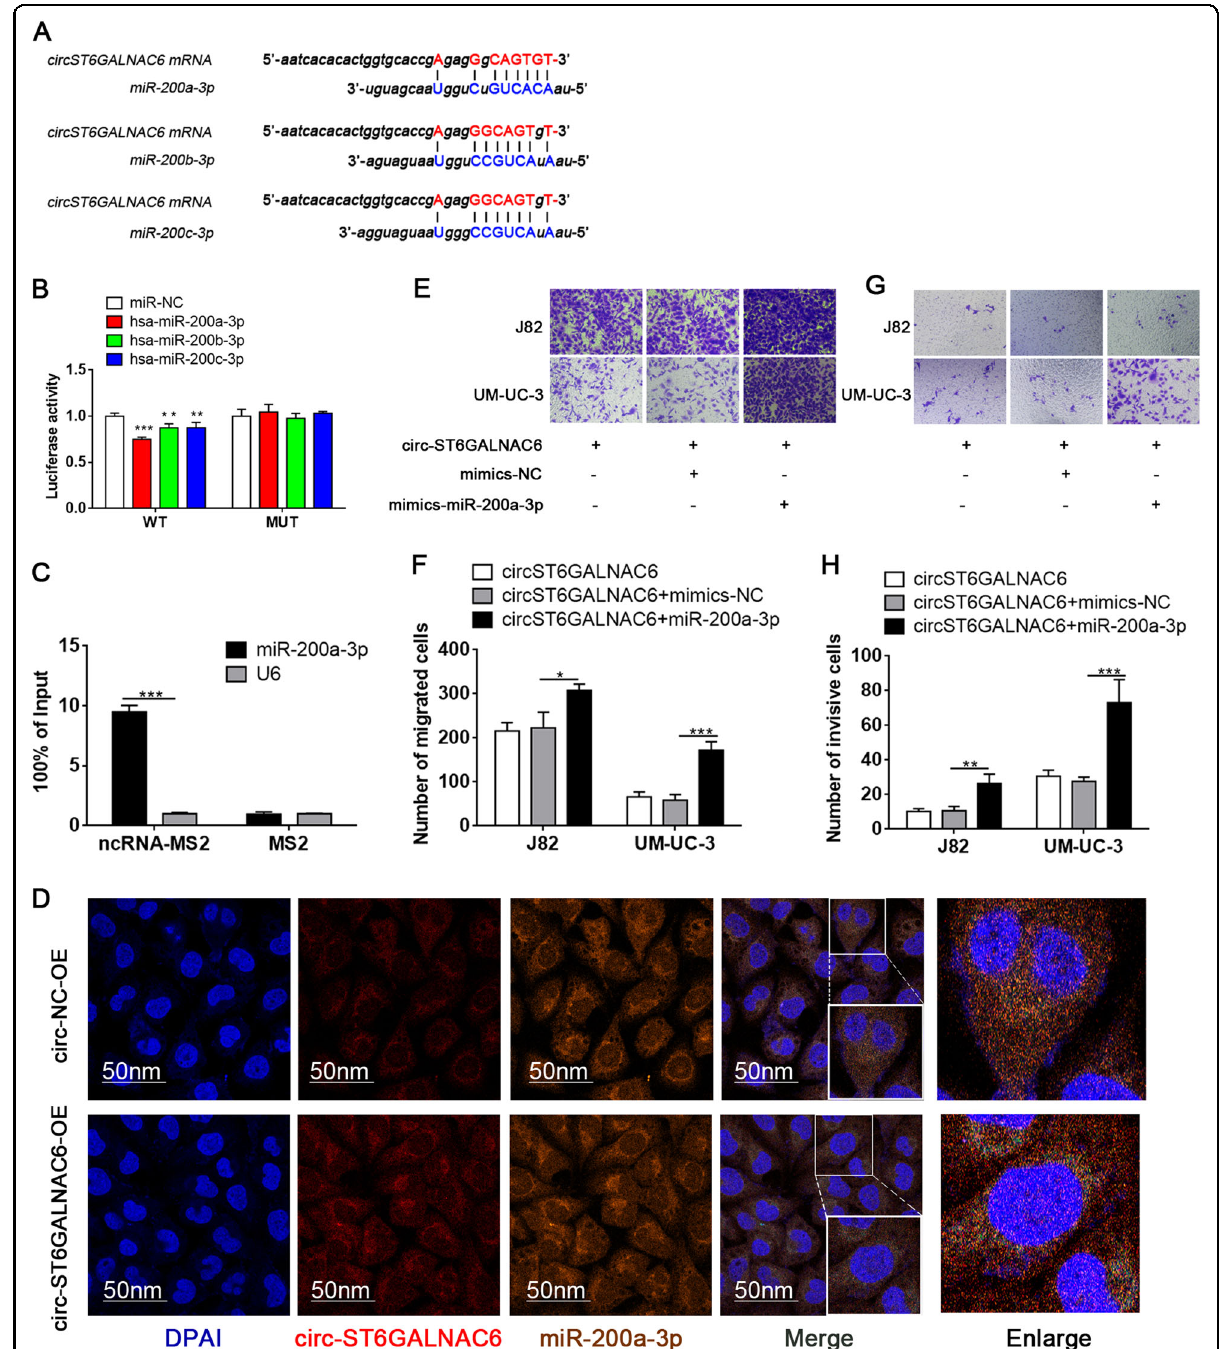
Fig. 4 circST6GALNAC6 acted as a miR-200a-3p sponge. A The putative binding sites of miR-200a/b/c-3p on circST6GALNAC6 are shown. B A luciferase reporter assay was performed to detect the activity of circST6GALNAC6 in 293T cells co-transfected with miR-200a/b/c-3p or scramble (miR- NC) and wild-type (WT) circST6GALNAC6 or mutated (MUT) circST6GALNAC6. C MS2-TRAP to analyse the binding of circST6GALNAC6 with miRNAs. D Colocalization of circST6GALNAC6 and miR-200-3p was measured using FISH in transfected J82 and UM-UC-3 cells. E – H The migration and invasion of transfected cells were analysed by Transwell assay. *** P < 0.001, ** P < 0.01 and * P <